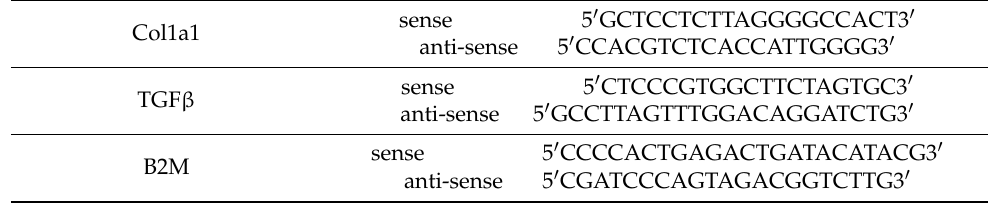
Figure 1. ApoE KO Mice fed an HFD or WD displayed increased body weight, body fat, fasting plasma glucose, plasma insulin and glucose intolerance. Initial body weight (before diet) ( A ); final body weight (after 7 weeks of HFD or WD) ( B ). Initial body fat (before diet) ( C ); final body fat (after 7 weeks of HFD or WD) ( D ); fasting plasma glucose ( E ). Area under curve (AUC) of plasma glucose at different times ( F ). Fasting plasma insulin ( G ). Homeostasis model assessment of insulin re- sistance (HOMA-IR) ( H ). Data are represented as mean ± SEM (N = 5 – 9). The statistical differences as indicated by one-way ANOVA were as follows: * p < 0.05 represents the difference between Chow (regular diet) vs. HFD; Chow (regular diet) vs. WD. 3.2. Increased Plasma Cholesterol, Hepatic Enzymes, and Hepatic Steatosis WD-fed mice displayed an increase in plasma total cholesterol by 111% compared with Chow-fed mice (Figure 2G). At the same time, there was no difference between the groups in plasma TAG concentration (Figure 2D). Mice fed an HFD or a WD also dis- played increased plasma concentration of hepatic enzymes, ALT and AST, when com- pared with Chow-fed mice (Figure 2E,F). Associated with these data, both HFD-fed and WD-fed mice showed increased hepatic steatosis compared with Chow-fed mice (Figure 2A – C).